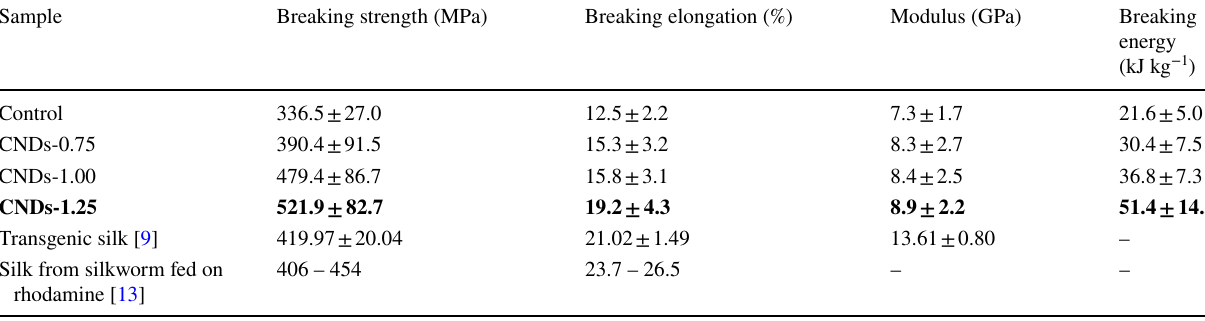
Table 1 Mechanical properties of intrinsically fluorescent degummed silk fibers